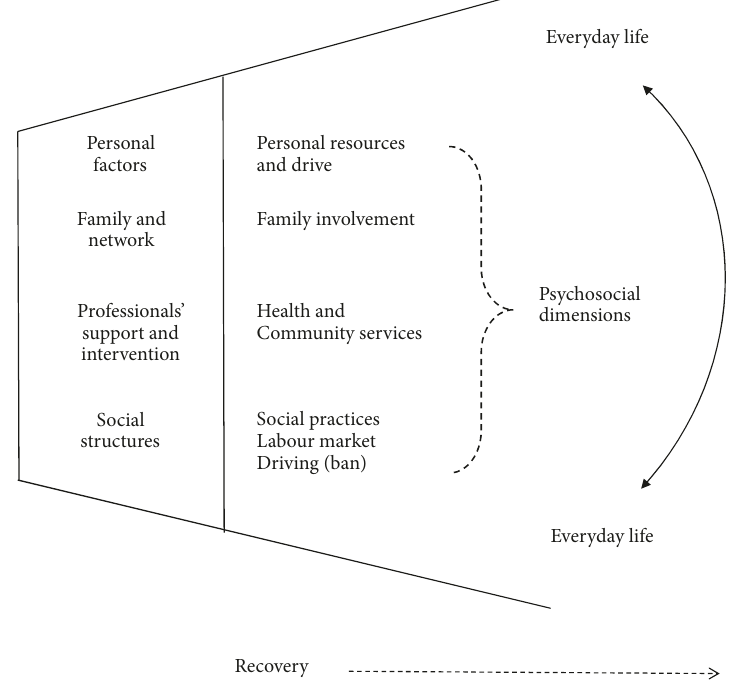
Figure 1: Gateway to